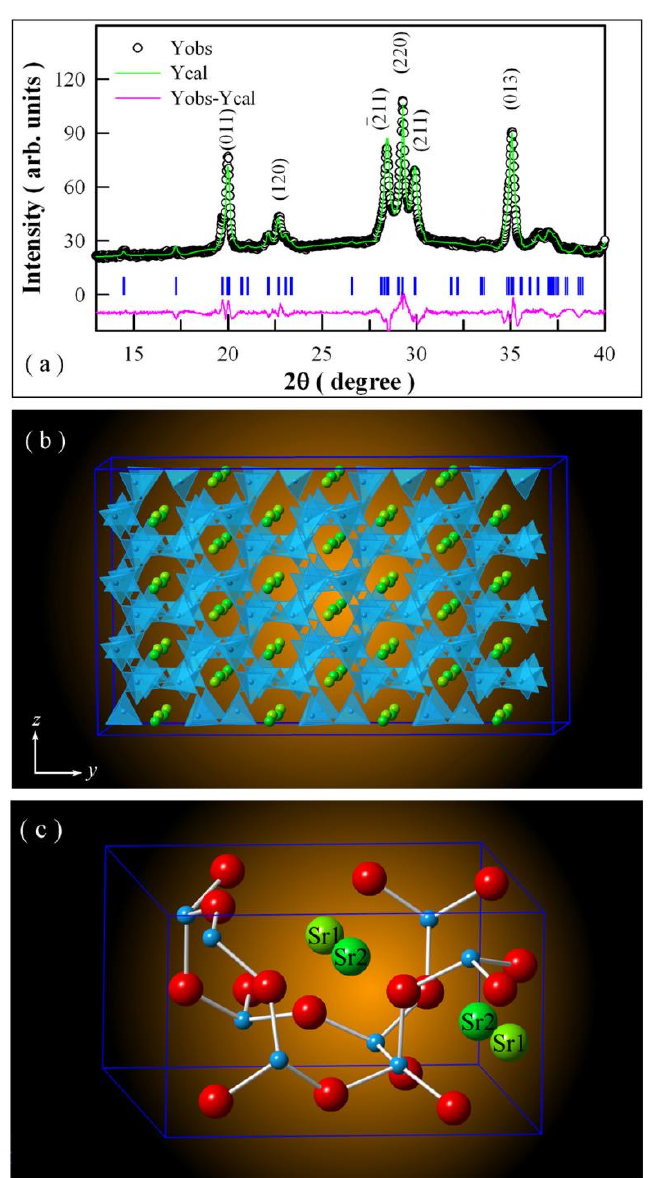
Figure 1. ( a ) XRD pattern of undoped SrAl 2 O 4 and its Rietveld refinement. Open circles: raw data; solid green curve: Rietveld diffractogram; solid pink curve: residue. ( b ) A supercell of SrAl 2 O 4 consisting of Sr 2+ ions situated in the channels of AlO4 tectrahedra. ( c ) Unit cell of SrAl 2 O 4 showing the two crystallographically different Sr sites.